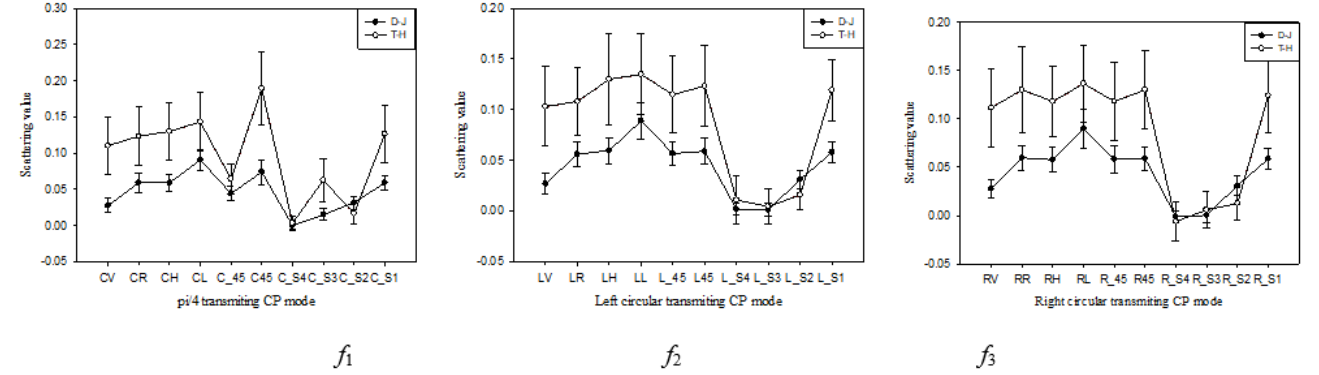
Figure 9. The CP parameters line diagram of two types of rice under three transmitting modes (( f 1 ):